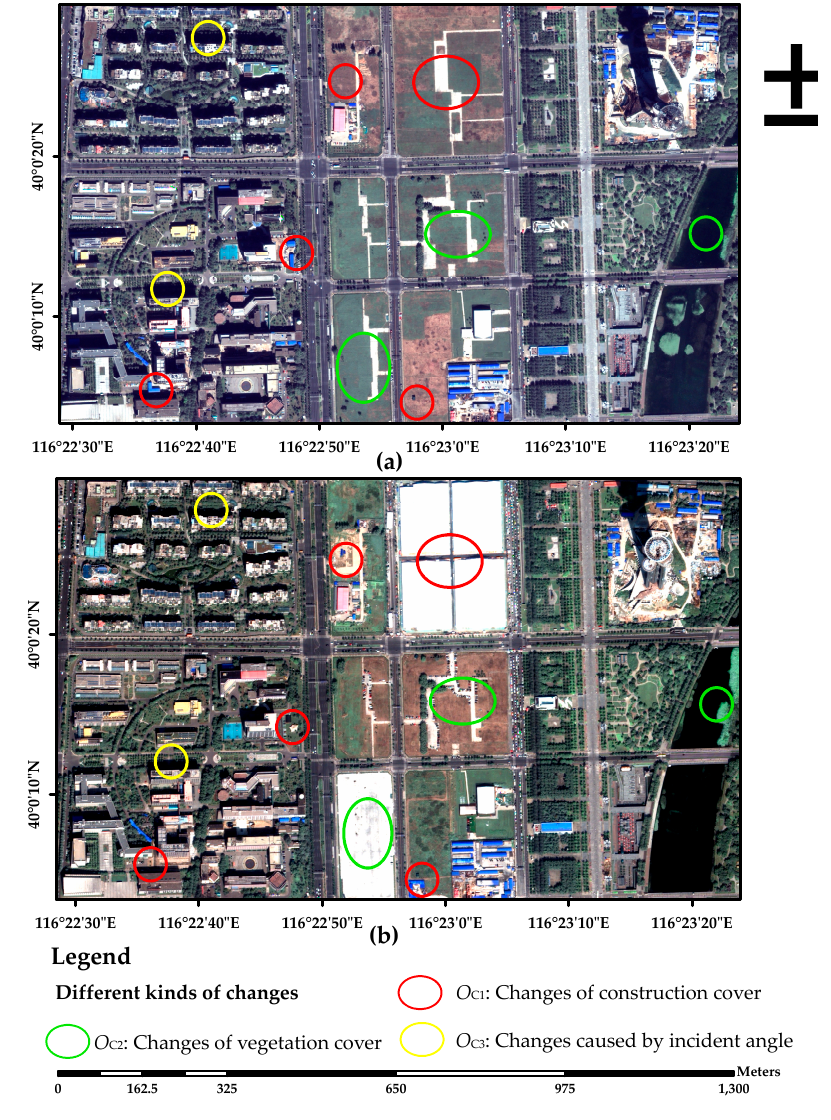
Figure 7. Ture color composition of images of study area nearby the Olympic Park of Beijing (China) acquired by Worldview-2 VHR fusion image on ( a ) 12 September 2012 and ( b ) 20 September 2013.